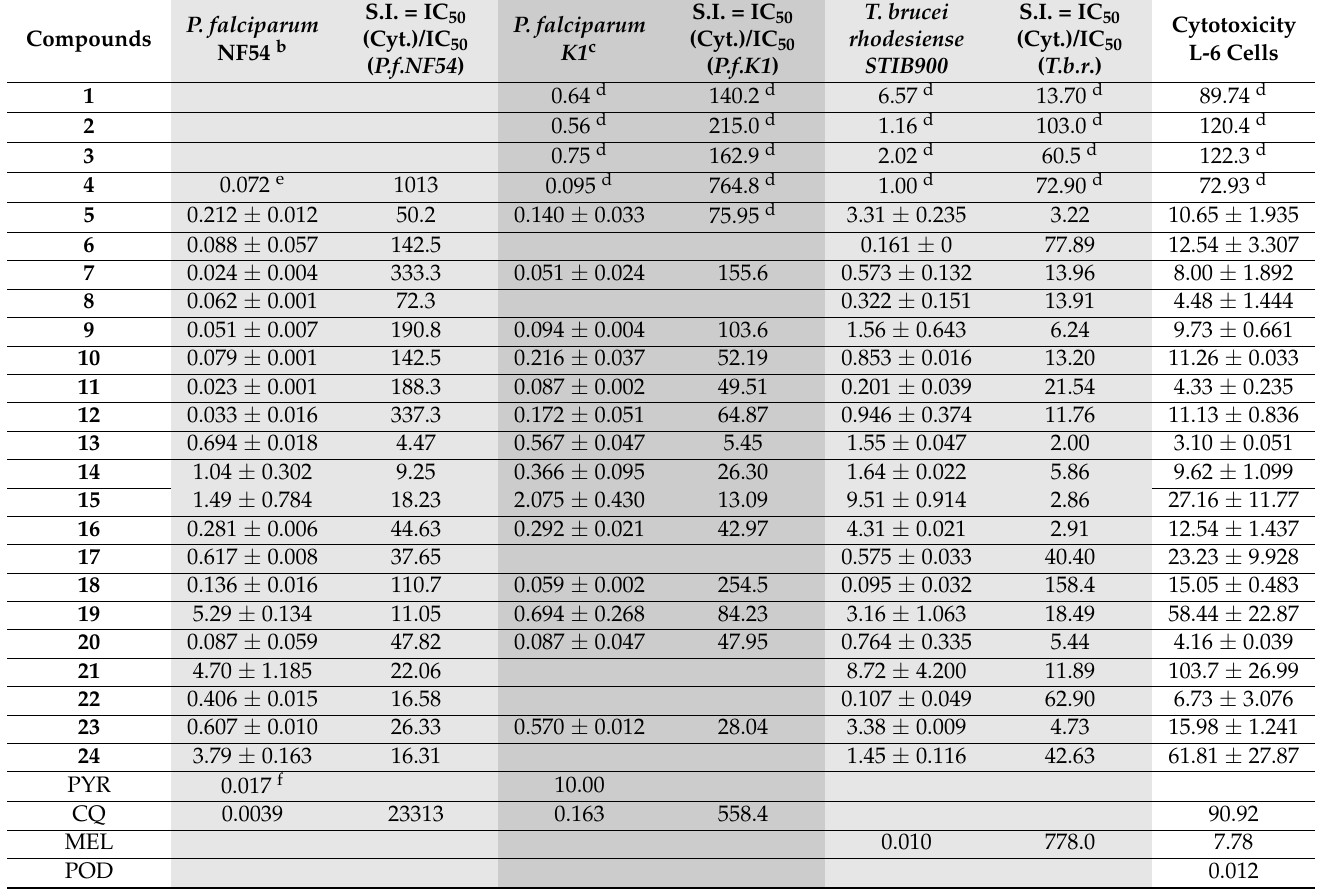
Table 1. Activities of compounds 1–24 against P. falciparum NF54, P. falciparum K1, T. brucei rhodesiense (STIB900) and L-6 cells, expressed as IC 50 ( µ M) a